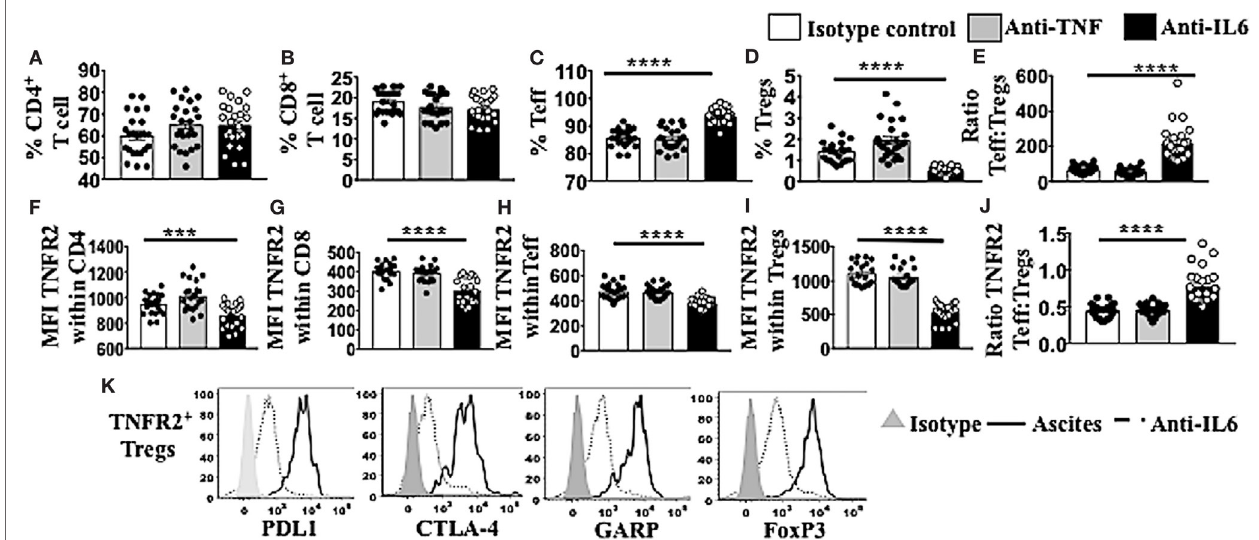
FigUre 6 | Blockade of bioctive interleukin 6 (IL-6), but not TNF, within ascites of epithelial ovarian cancer (EOC) patients decreases percentage of regulatory T cells (Tregs) as well as TNFR2 + Tregs, as well as tumor necrosis factor receptor 2 (TNFR2) expression. Peripheral blood mononuclear cells (PBMCs) from healthy donors ( n = 30) were isolated by Ficoll density centrifugation and incubated in vitro in either AIM V media or cell-free ascites from advanced EOC patients for 48 h. IL-6 and tumor necrosis factor (TNF) within the ascites were blocked with mouse anti-human IL-6 monoclonal antibody (mAb) at 2.5 μ g/ml and mouse anti-human TNF at 500 ng/ml. Mouse IgG1 immunoglobulins (isotype control) were used as a negative control. Cells were washed, labeled for surface and intracellular markers CD3, CD4, CD8, CD25, TNFR2, programmed cell death ligand-1 (PD-L1), CTLA-4, GARP, and FoxP3, and analyzed with flow cytometry. (a–e) The frequency (%) of CD4, CD8, T effector (Teff), and Treg (a–D) and the ratio of Teff to Tregs (e) within ascites following blockade with IL-6 (black bar) or TNF (gray bar). (F–J) The level of TNFR2 expression (median fluorescence intensity, MFI) within CD4, CD8, Teff, and Tregs (F–i) and ratio of TNFR2 expressing Teff to Tregs (J) in ascites following IL-6 or TNF blockade. (K) PD-L1, CTLA-4, GARP, and FoxP3 expression on TNFR2 + Tregs cells incubated in ascites (solid line) and following blockade with IL-6 mAb (dashed line). The shaded (gray) histogram represents staining with an isotype control. * p < 0.05, ** p = 0.001–0.01, *** p = 0.0001–0.001, **** p < 0.0001, One-way ANOVA and Dunn’s multiple comparison test (post hoc). Data are pooled from three independent experiments (error